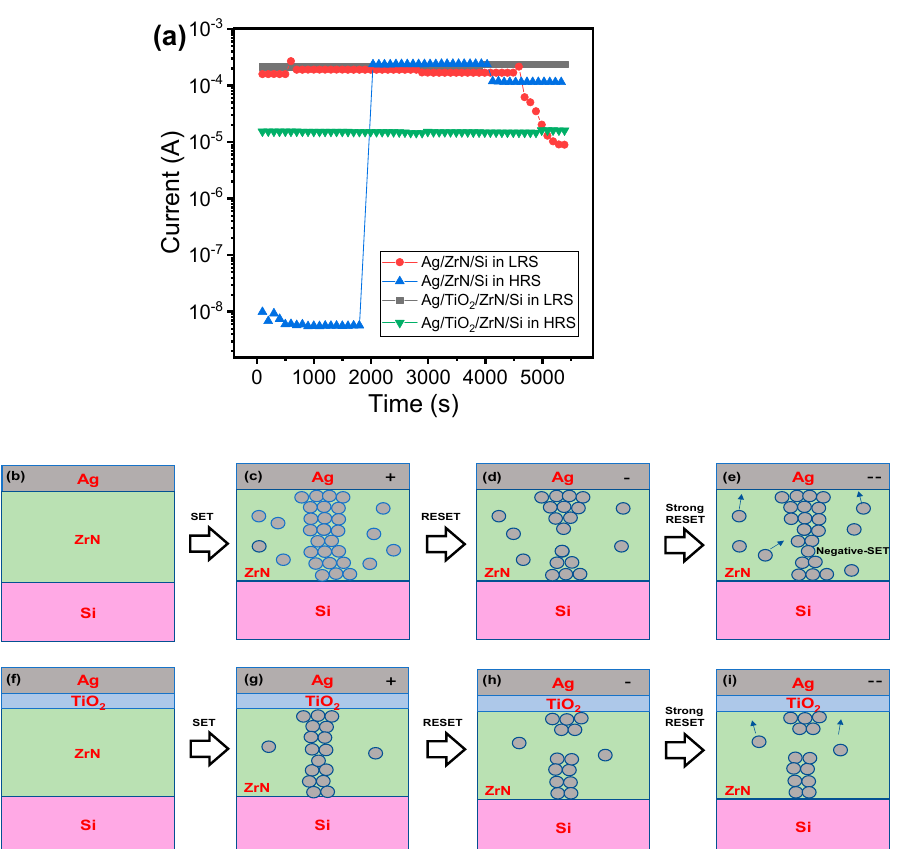
Figure 6. ( a ) Retention test for 5000 s for Ag/ZrN/Si and Ag/TiO 2 /ZrN/Si devices in the low-resistance state (LRS) and high-resistance state (HRS); Ag filament overgrowth and negative-SET in Ag/ZrN/Si device. ( b ) Initial state; ( c ) filament overgrowth in LRS after SET process; ( d ) HRS after the RESET process; ( e ) Additional filament growth through larger RESET voltage; filament evolution for Ag/TiO 2 /ZrN/Si device in the LRS and HRS; ( f ) initial state; ( g ) LRS with smaller size of filament after SET process; ( h ) HRS after RESET process; ( i ) filament is maintained with higher voltage without